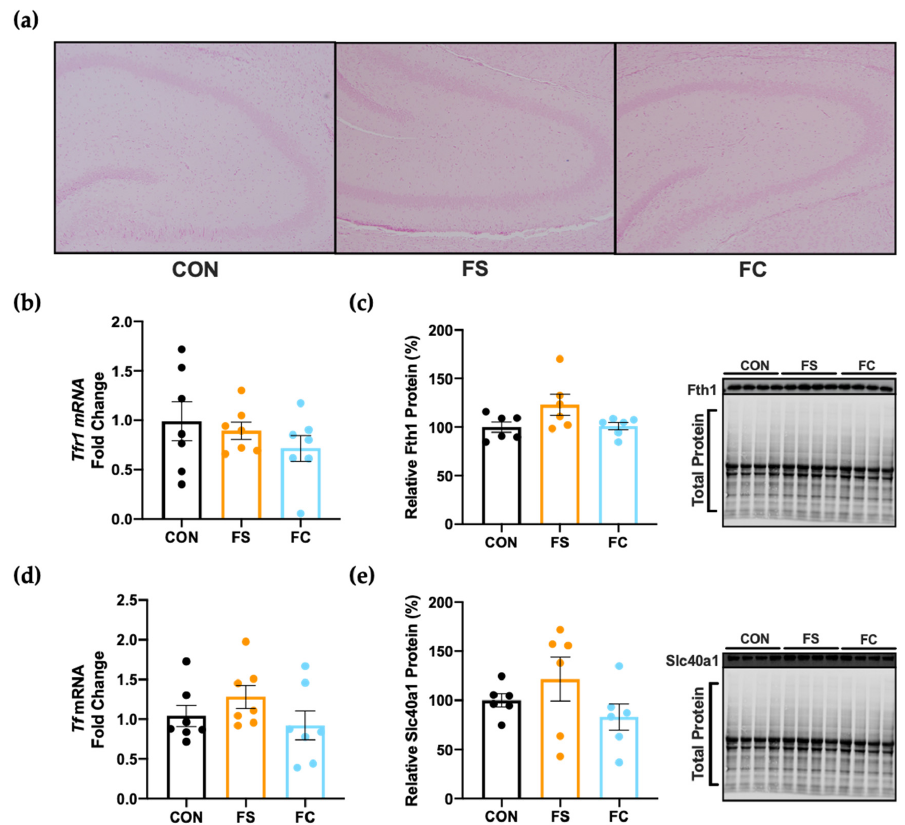
Figure 4. Hippocampal iron loading and regulation on PD 15. ( a ) Representative microscope images of hippocampal sections stained with Perls’ Prussian blue stain for ferric iron detection, captured with 10x objective lens ( n = 5–6/group). ( b ) Transferrin receptor ( Tfr1 ) and ( d ) transferrin ( Tf ) mRNA expression in hippocampal tissue, shown as fold change relative to CON ( n = 7/group). ( c ) Hippocampal expression of ferritin heavy chain (Fth1) subunit, and ( e ) iron exporter protein ferroportin (Slc40a1) expression were normalized to total protein using the Stain-Free ™ method and plotted relative (%) to CON expression ( n = 6/group). Representative blots shown on the right with total protein. Values are shown as the means ± SEM.